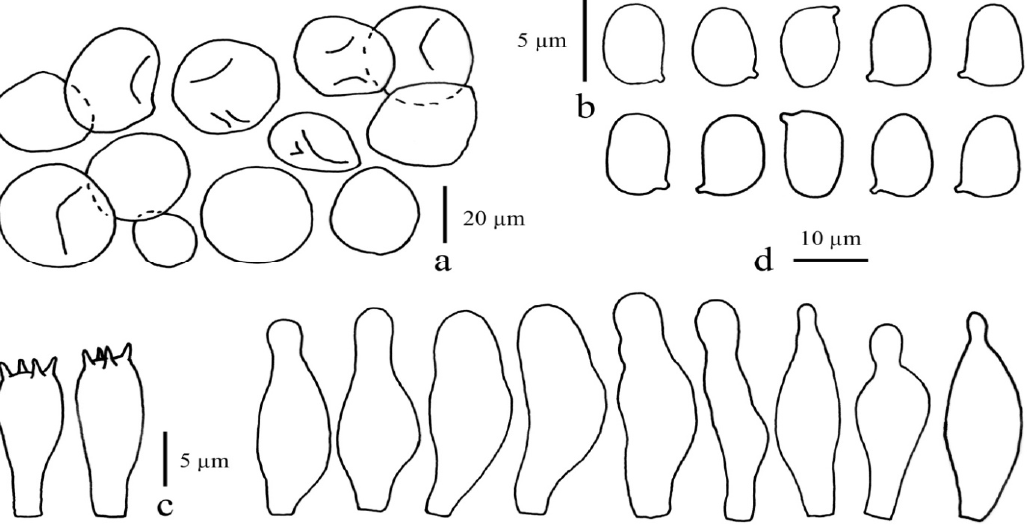
Figure 3 . Microcharacters of Cystolepiota pyramidalis (HNL502500, holotype). ( a ) = elements of pileus covering, ( b ) = basidiospores, ( c ) = basidia, ( d ) = cheilocystidia. 3.2.2. Cystolepiota thailandica Yuan S. Liu, Sysouph. and Thongkl. sp. nov.